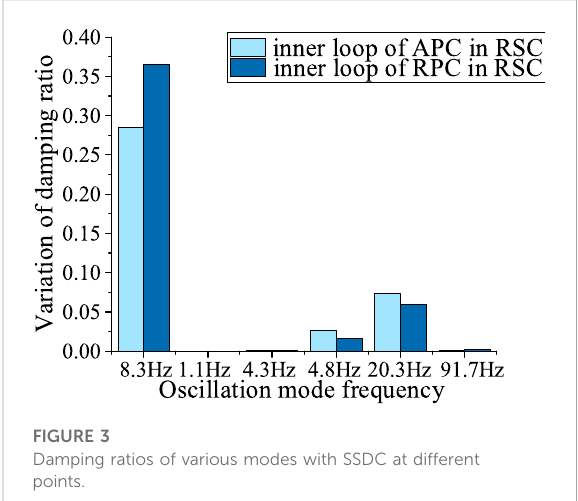
FIGURE 3 Damping ratios of various modes with SSDC at different points.